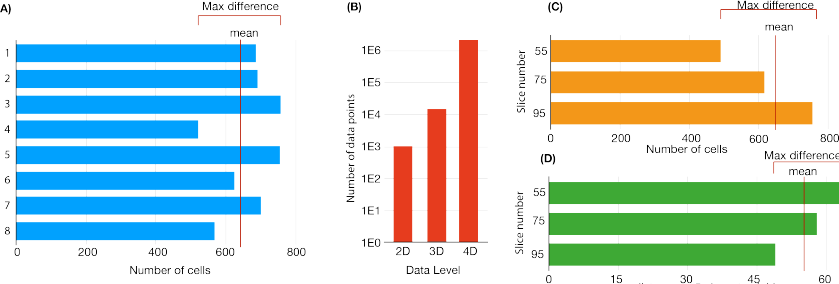
Figure 3. ( A ) Bar plots comparing manual quantification of the same image from trained users, using FIJI Cell Counter to assist with the quantification. Difference between users can be up to 35% of the mean value. ( B ) Increase in the number of data points to be processed when taking into account different dimensional levels of the developing vertebrate retina (vertical axis in log scale to help visualize the changes in terms of orders of magnitude). ( C ) Automated quantification of the number of nuclei of three different slices of a 3D stack of a given retina, showing differences up to 44% of the mean value. ( D ) Quantification of the nuclei density in terms of the average distance to the five closest nuclei show variations of 25% across the three different sections analyzed. Images are processed in FIJI, using an auto-threshold followed by the watershed algorithm. The number of objects is obtained from FIJI’s Analyze